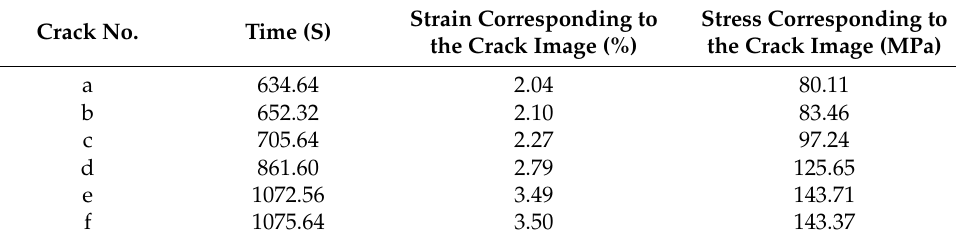
Table 2. Stress and strain values corresponding to the static crack images. Strain Corresponding to Stress Corresponding to Crack No. Time (S) the Crack Image (%) the Crack Image (MPa) 634.64